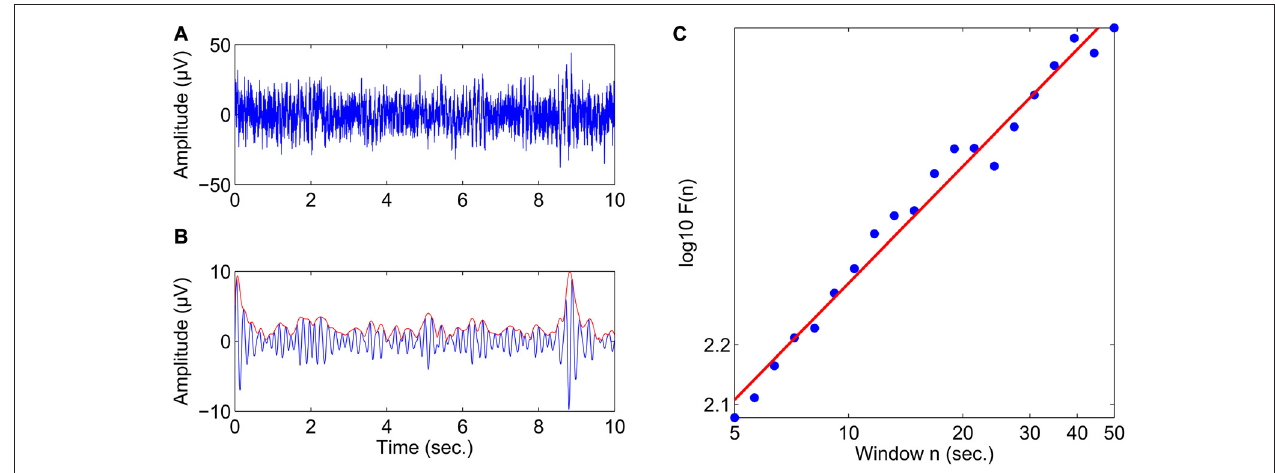
FIGURE 1 | Estimating the scaling exponent of neuronal oscillations with DFA. (A) 10 s of broadband EEG from the Fz electrode in a healthy subject. (B) The theta-band activity is obtained from the signal in (A) using bandpass filtering (4–7 Hz) and the Hilbert transform is used to extract the amplitude envelope ( red line ). (C) The DFA fluctuation function, F ( n ), scales linearly with window size, n , in the range of 5–50 s in double-logarithmic coordinates. The slope of the least-squares line is the scaling exponent, which in this case was